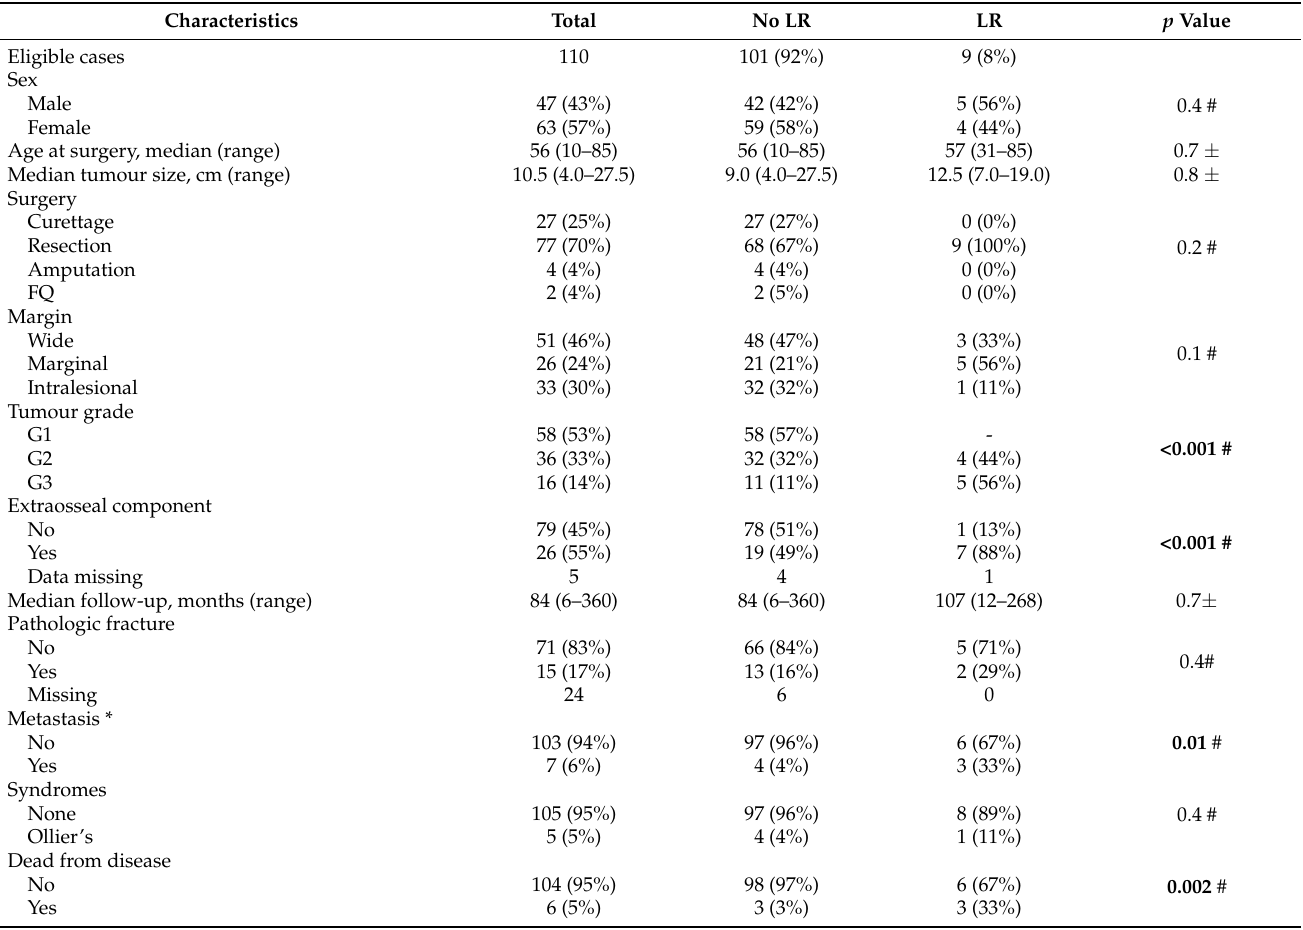
Figure 2. The role of grade in local recurrence free survival. The margin was not a statistically significant predictor for LRFS, neither when all grades were combined ( p = 0.8) nor when stratified according to grade (grade 1, p = 1; grade 2, p = 0.4; or grade 3, p = 0.1). The role of LR is summarized in Table 2. Table 2. Nine local recurrences of 110 conventional central proximal humerus chondrosarcoma cases (values are presented in number of